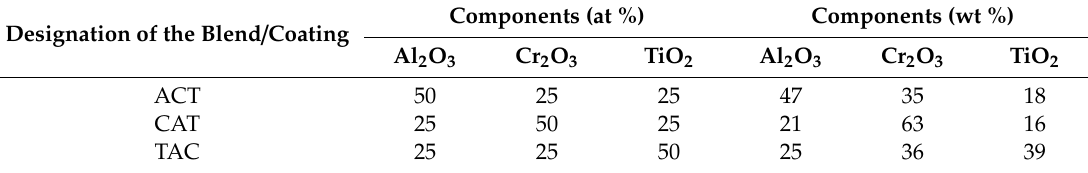
Table 2. Compositions of the powder